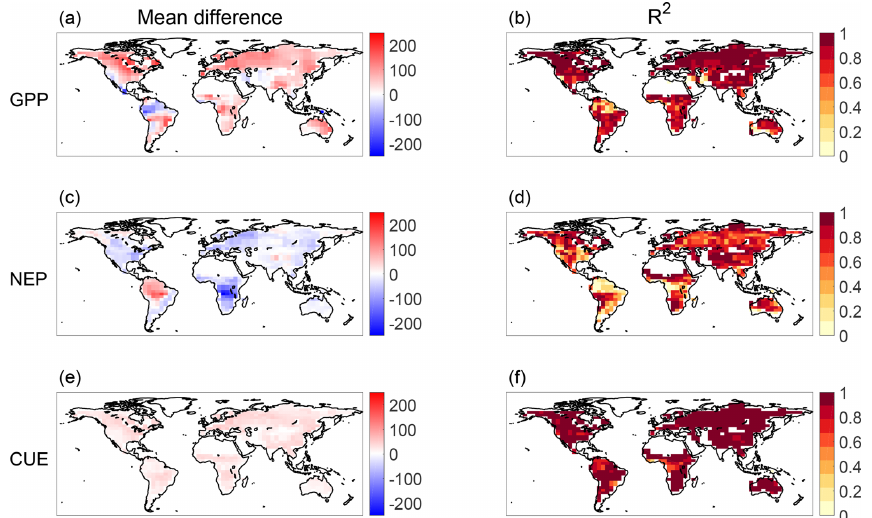
Figure 4. Results of sensitivity analyses for three input datasets. (a, c, e) Mean difference (gCm 2 yr − 1 ) between baseline top-down R h and alternate-input top-down R h and (b, d, f) R 2 between baseline top-down R h and alternate-input top-down R h . Sensitivity analyses performed include using FLUXCOM GPP (a, b) , assuming uniformly zero values of NEP (c, d) and that CUE varies temporally in a manner proportional to GPP (e, f) .